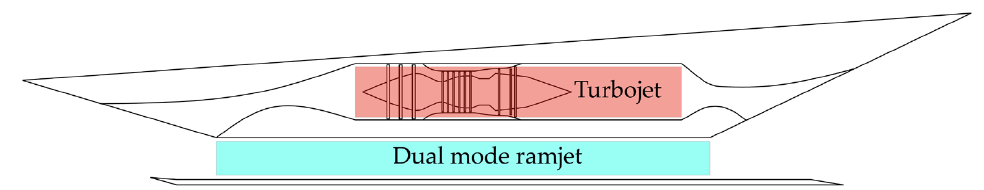
Figure 2. Diagram of propulsion system.